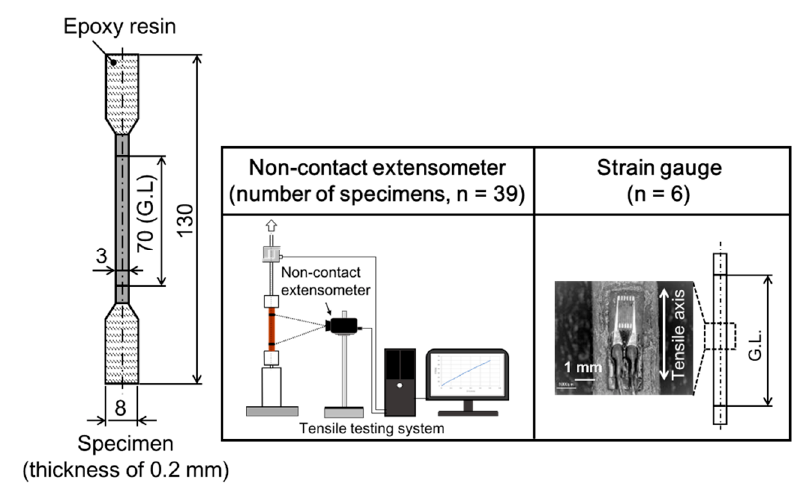
Figure 5. The experimental information e in the present study.